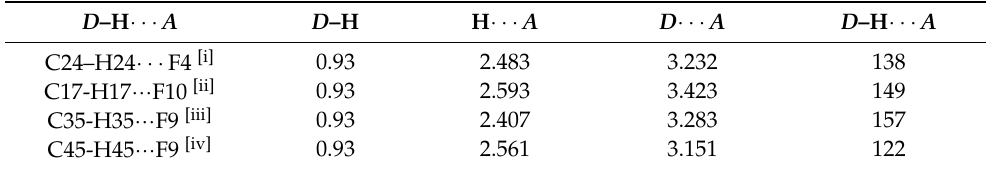
Table 4. Hydrogen-bonds geometry (Å, ◦ ) of 3Hg